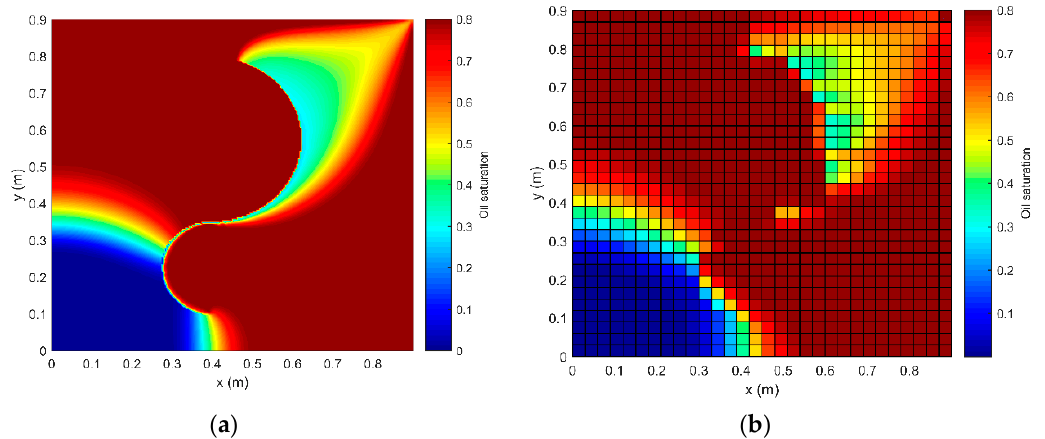
Figure 13. Profiles of oil saturation after 115 days’ injection for Case 3 in ( a ) the fine-grid model and ( b ) iEDFM (30 × 30).